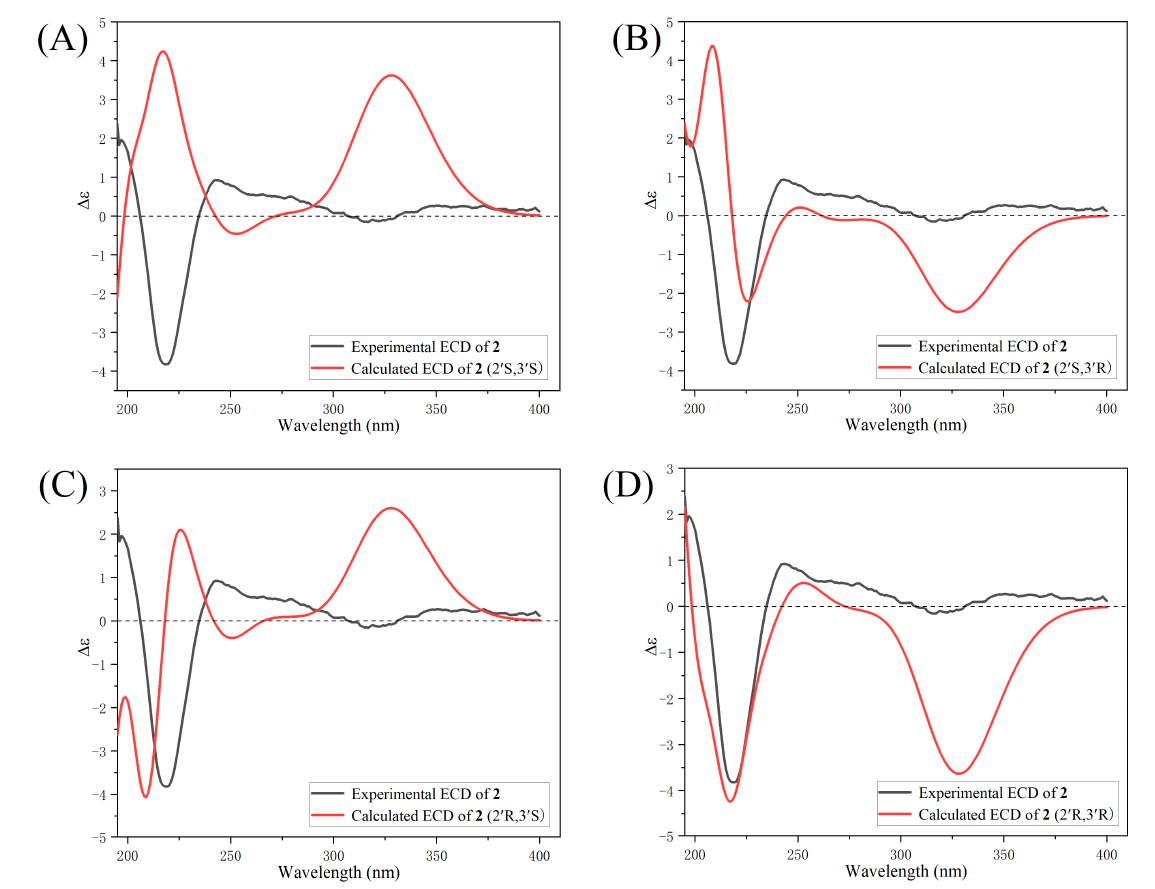
Figure 3. ( A ): Experimental ECD of 2 and calculated ECD of (2 ′ S,3 ′ S) - 2 ; ( B ): Experimental ECD of 2 and calculated ECD of (2 ′ S,3 ′ R) - 2 ; ( C ): Experimental ECD of 2 and calculated ECD of (2 ′ R,3 ′ S) - 2 ; ( D ): Experimental ECD of 2 and calculated ECD of (2 ′ R,3 ′ R) - 2 . Myricetin ( 3 ). Yellow powder. 1 H-NMR (CD 3 OD, 400 MHz) δ : 7.76 (2H, d, J = 8.8 Hz, Quercetin ( 5 ). Yellow powder. 1 H-NMR (CD 3 OD, 400 MHz) δ : 7.74 (1H, d, J = 2.0 Hz, H-2 (cid:48) ), 7.63 (1H, dd, J = 8.4, 2.0 Hz, H-6 (cid:48) ), 6.88 (1H, d, J = 8.8 Hz, H-5 (cid:48) ), 6.39 (1H, d, J = 1.6